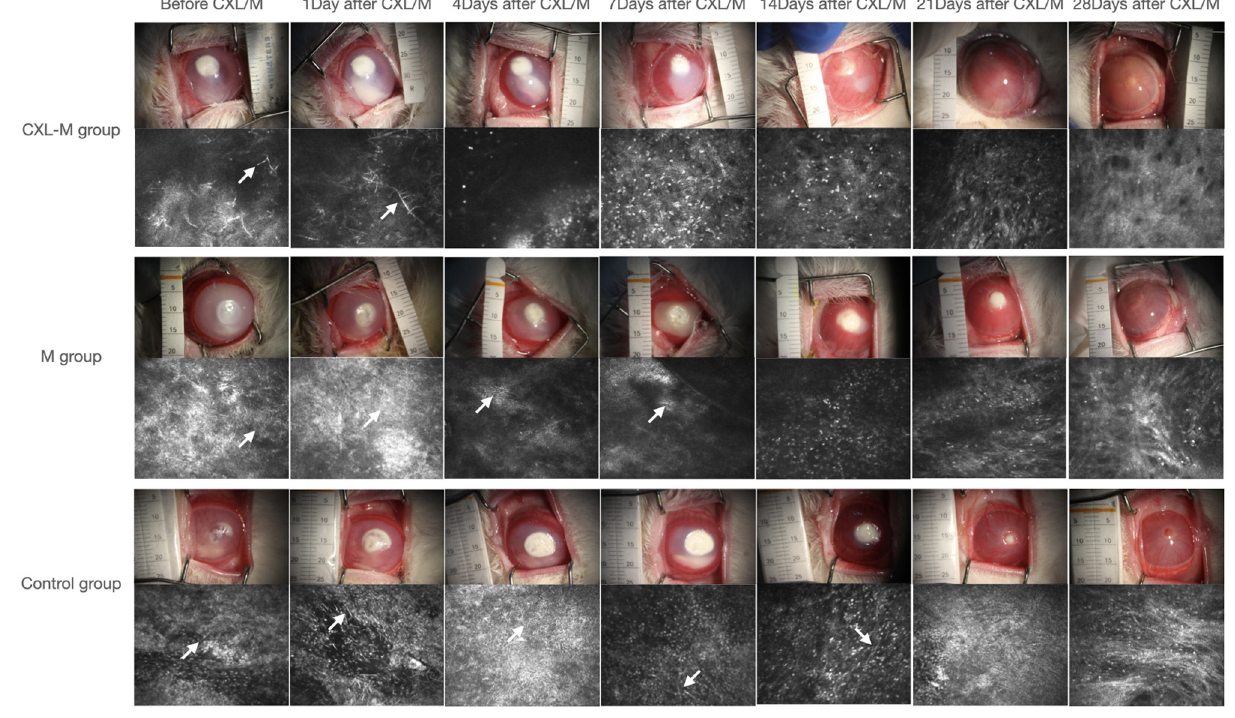
maximum ulcer depth and corneal and epithelial